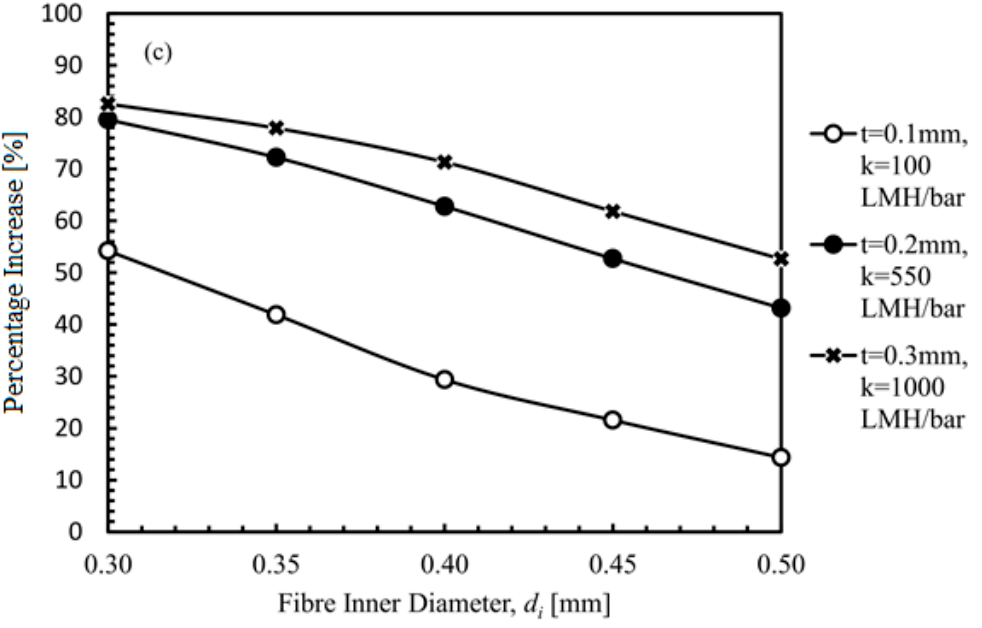
Figure 7. Relationship between fibre inner diameter and output flow rate for different membrane thickness and permeability. ( a ) Single-end suction; ( b ) Double-end suction; ( c ) Percentage increase.